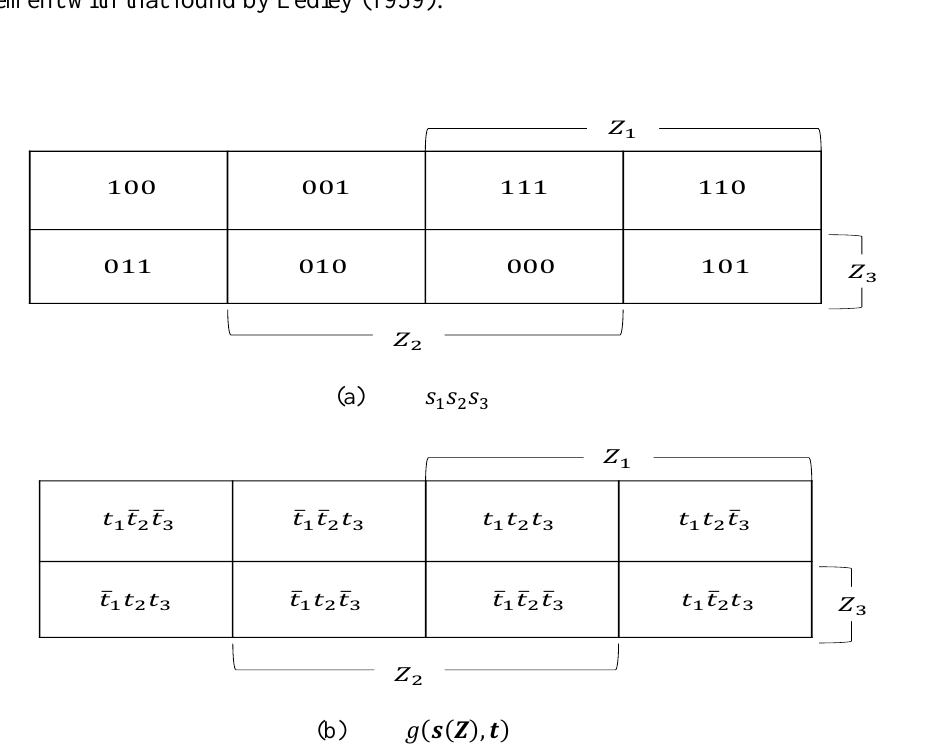
, 𝑠 , 𝑠 , and 𝑔(𝒔(𝒁), 1 2 3